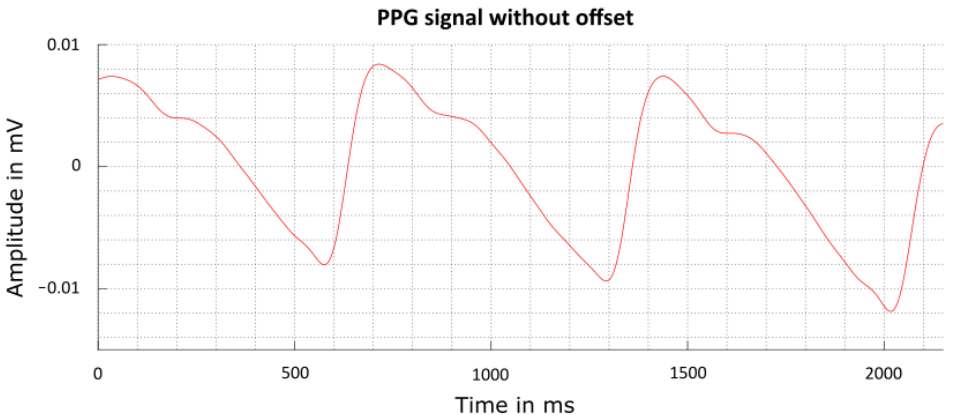
Figure 10. Digitally filtered PPG wave signal that was recorded with SPECTRE 3.0 and processed by the evaluation